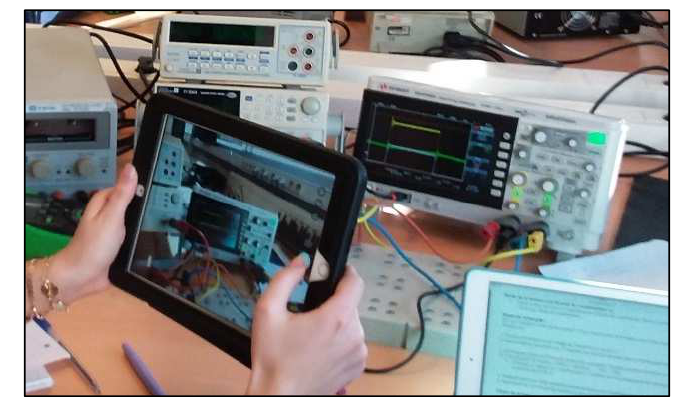
Figure 1. Etudiant prenant une photographie des résultats expérimentaux